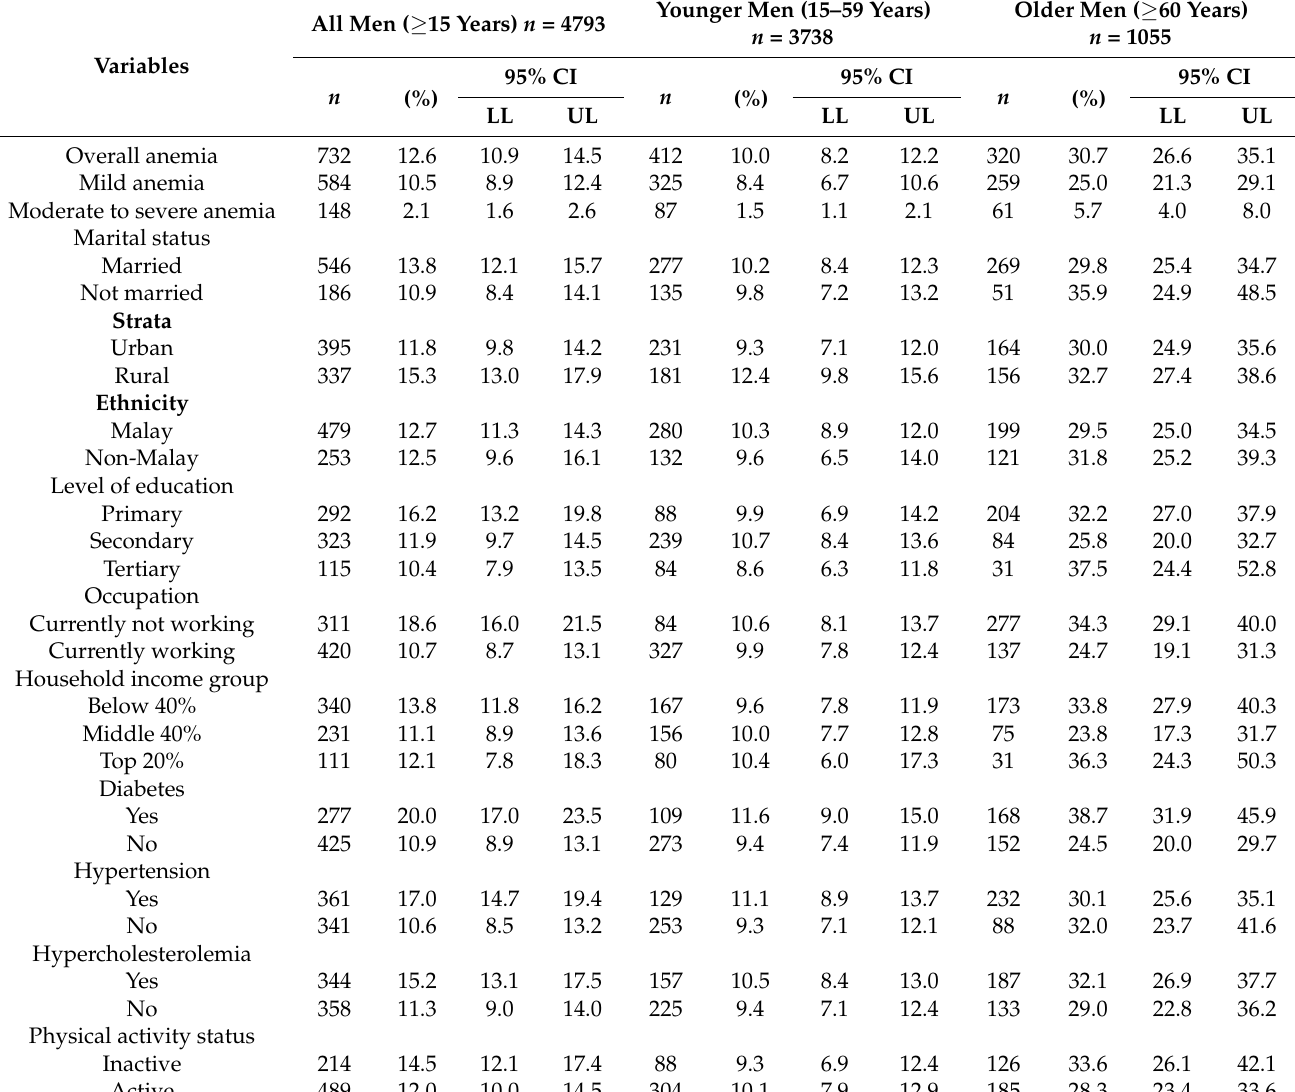
Table 1. Prevalence of anemia among men in Malaysia according to socio-demographic profiles, chronic diseases and lifestyle